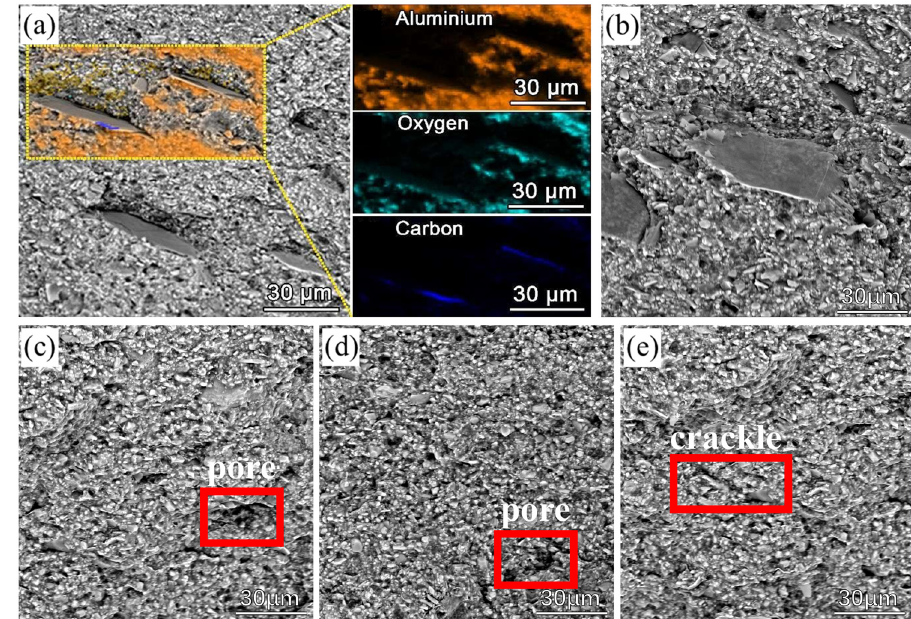
Figure 6: SEM cross section of PP samples with di ff erent A153 content: ( a ) PP - 1, ( b ) PP - 2, ( c ) PP - 3, ( d ) PP - 4, and ( e ) PP -